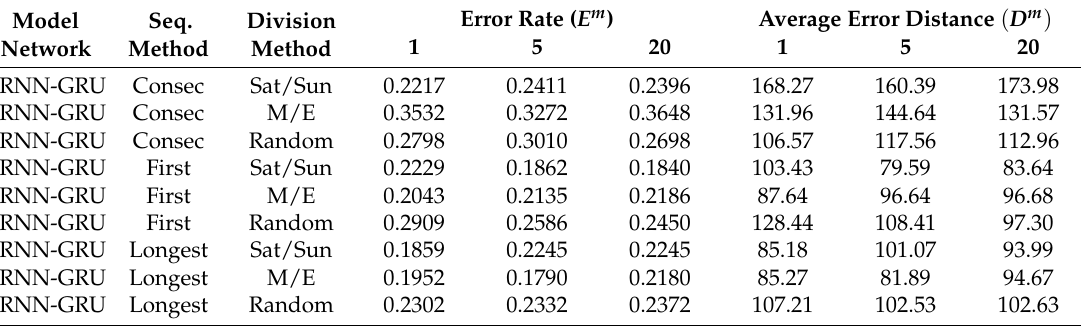
Table 3. Summary of cross-validation results for distinct sequencing methods and divisions between training and testing data